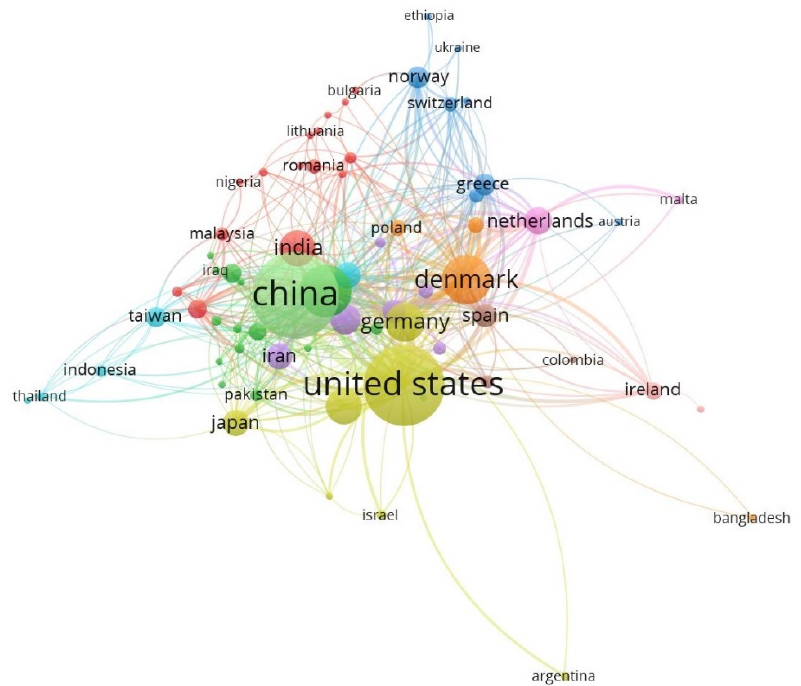
Figure 2. Worldwide collaborations between countries on optimizing wind turbine efficiency.